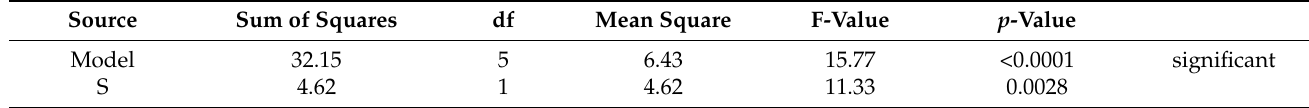
Table 9. ANOVA table for second output response